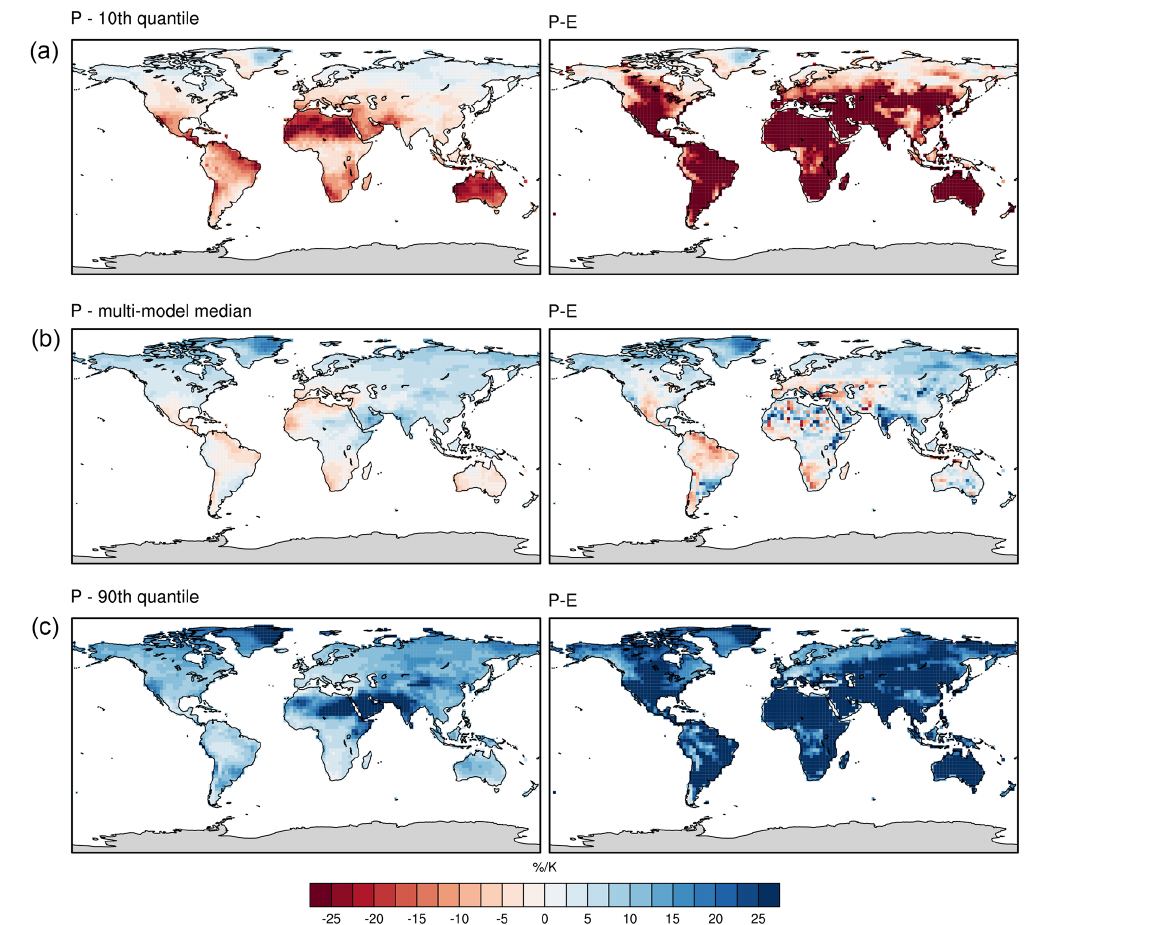
Figure 2. Median (b) , 10th (a) and 90th quantiles (c) of the sensitivity of P (left panels) and P − E (right panels) to changes in global mean temperature (%K − 1 ). A total of 14 CMIP5 models and all scenarios (RCP2.6, RCP4.5, RCP6.0, RCP8.5) are